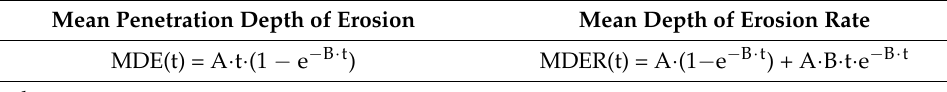
Table 3. Parameters used to evaluate the cumulative mean depth of erosion (MDE), respectively, the erosion penetration rate